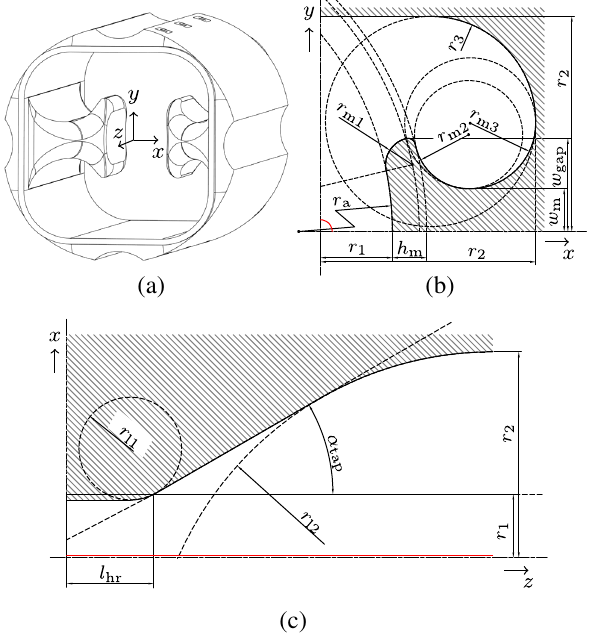
FIG. 1. Design of the wide-open-waveguide crab cavity (WOWCC). (a) Perspective view of the finalized cavity shape. Bunches are deflected in the horizontal direction by the electric field created between the two mushroom-shaped ridges. A quarter of the transverse and longitudinal cross section with the various design parameters are shown in (b) and (c), respectively. The location of the beam is highlighted in